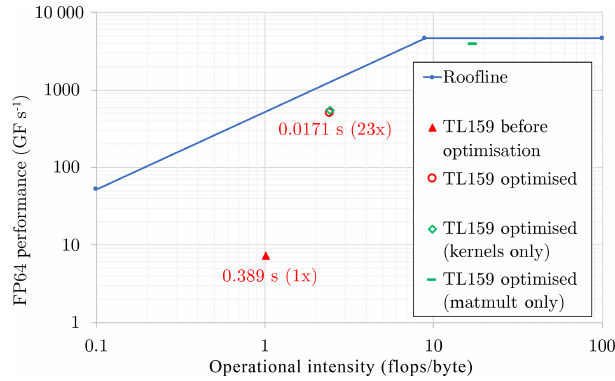
Figure 5. Roofline plot for the spectral transform dwarf at 125km resolution ( N T = 159) on the NVIDIA Tesla P100 GPU. The full time step of the original prototype is represented by the solid red triangle. The corresponding time step for the optimised prototype is represented by the red circle. Also included are partial results for kernels only (open green diamond atop the red circle) and ma- trix multiplication only (green dash). Each point is positioned in the plot according to its operational intensity: points under the sloping region of the roofline are limited by available memory bandwidth, and points under the horizontal region are limited by peak compu- tational